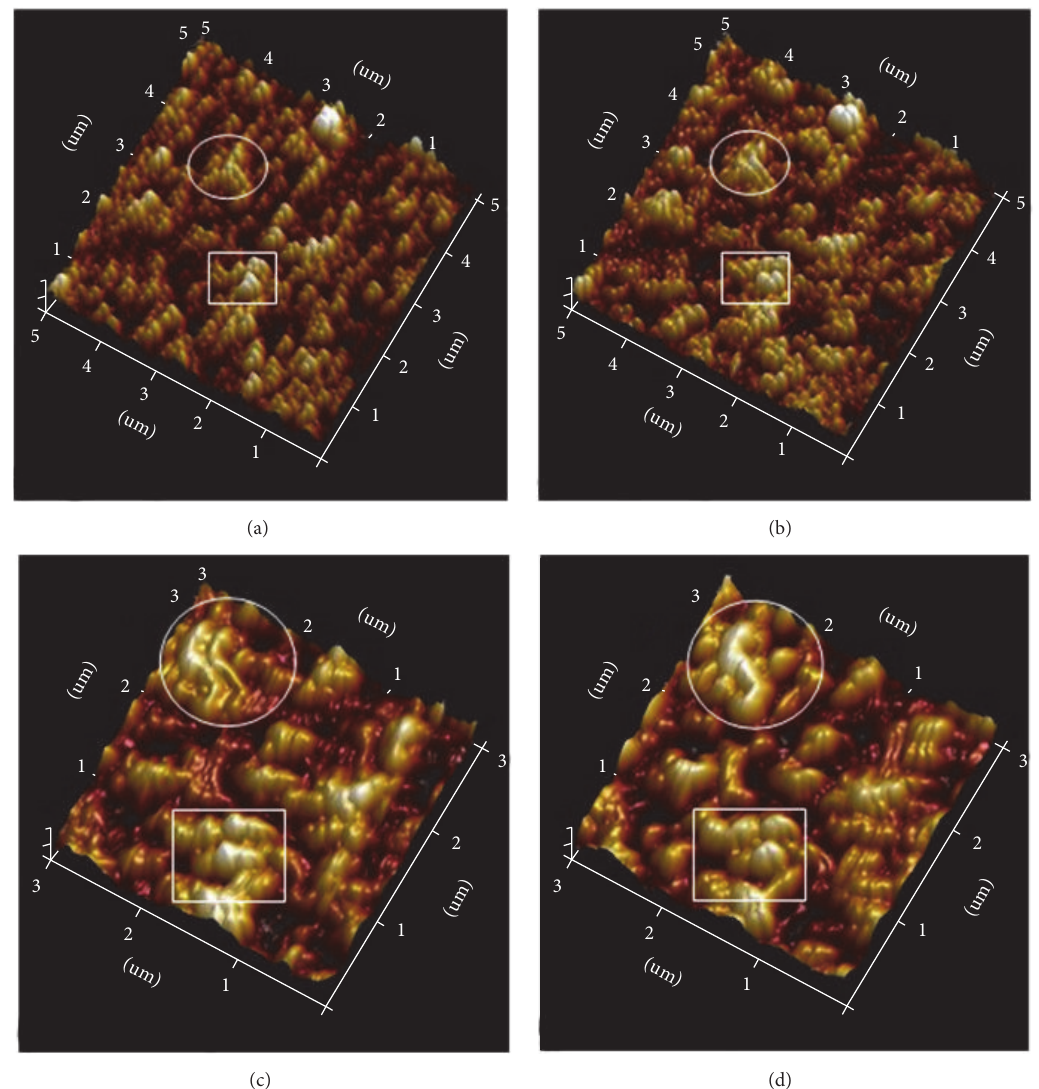
Figure 1: 3D surface topography AFM images of the CH 3 NH 3 PbI 3 perovskite films with mp-TiO 2 /bl-TiO 2 /FTO structure which applied DC biases voltage and AC voltage groups are (a) (0V, 0 V), (b) ( ∼ 8V, 0 V), (c) ( ∼ 8V, +3V), and (d) ( ∼ 8V, +6 V). (a), (b), (c), and (d) are the same substrate and the same position. In order to see clearly, (c) and (d) are the enlargement of the center of (a) and